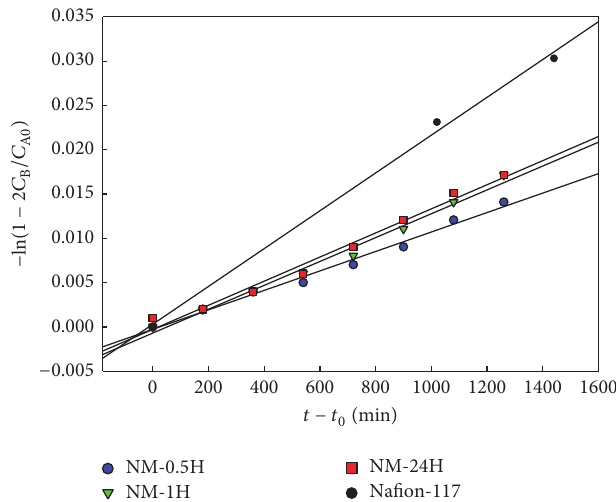
Figure 7: The vanadium concentration is plotted as a function of time according to